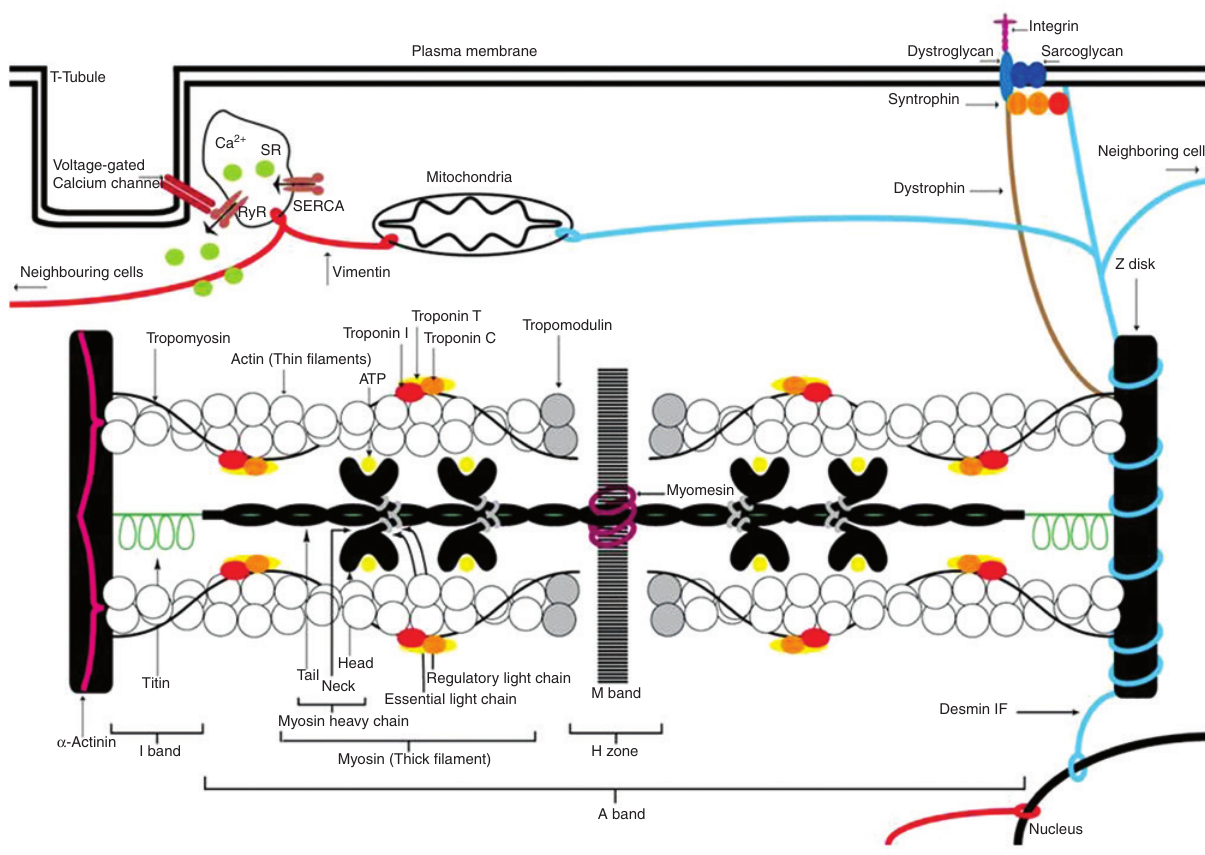
Figure 1: A striated muscle cell highlighting key sarcomeric, cytoskeletal, and sarcolemmal proteins as well as intracellular organelles. The main constituents of the sarcomere are thin and thick filaments, which are composed of actin and myosin, respectively. Troponin and tropomyosin associate with actin polymers and play an integral role in striated muscle contraction. The M-line and Z-disk are connected via titin and together constitute the framework of the sarcomere. Muscle cells contain several intermediate filaments (IF) including desmin, vimentin, nestin, synemin, syncoilin. IFs also participate in signaling cascades that are linked to both integrin and dystroglycan complex (DGC) signaling. Integrins have a structural role as extracellular matrix (ECM) proteins mediating attachment between the cell and the sur- rounding